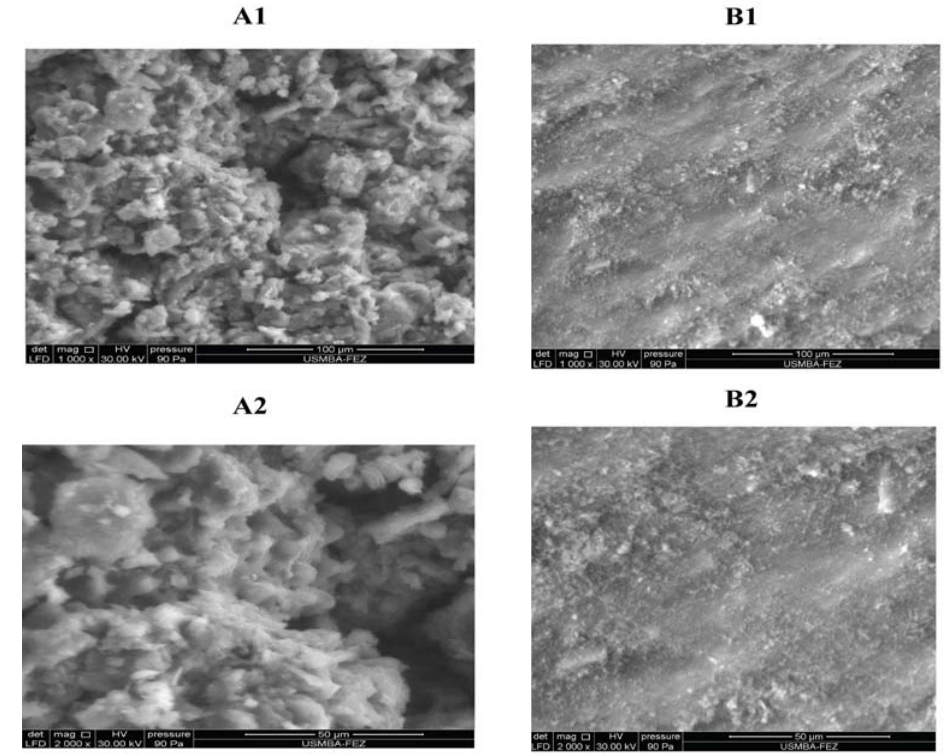
Figure 4 . SEM pictures of the FS natural clay (A1-A2) and Fau Y zeolite